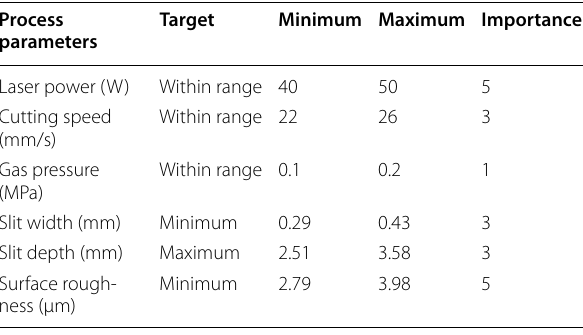
Table 7 Variation range and importance of inert gas-assisted